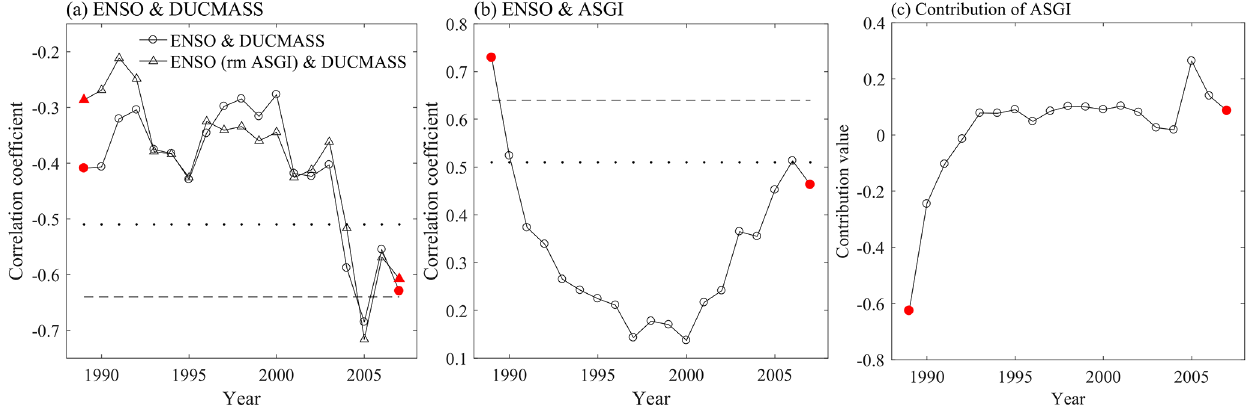
Figure 4. (a) The 15-year sliding correlation between DUCMASS and Niño-3 with and without ASGI-related signals removed; (b) 15-year sliding correlation between Niño-3 and ASGI; (c) sliding contribution of ASGI to the DUCMASS–Niño-3 relationship. The two red-filled markers represented the 15-year window spanning from 1982 to 1996 and from 2000 to 2014, respectively. The x axis denotes the middle year of the period under